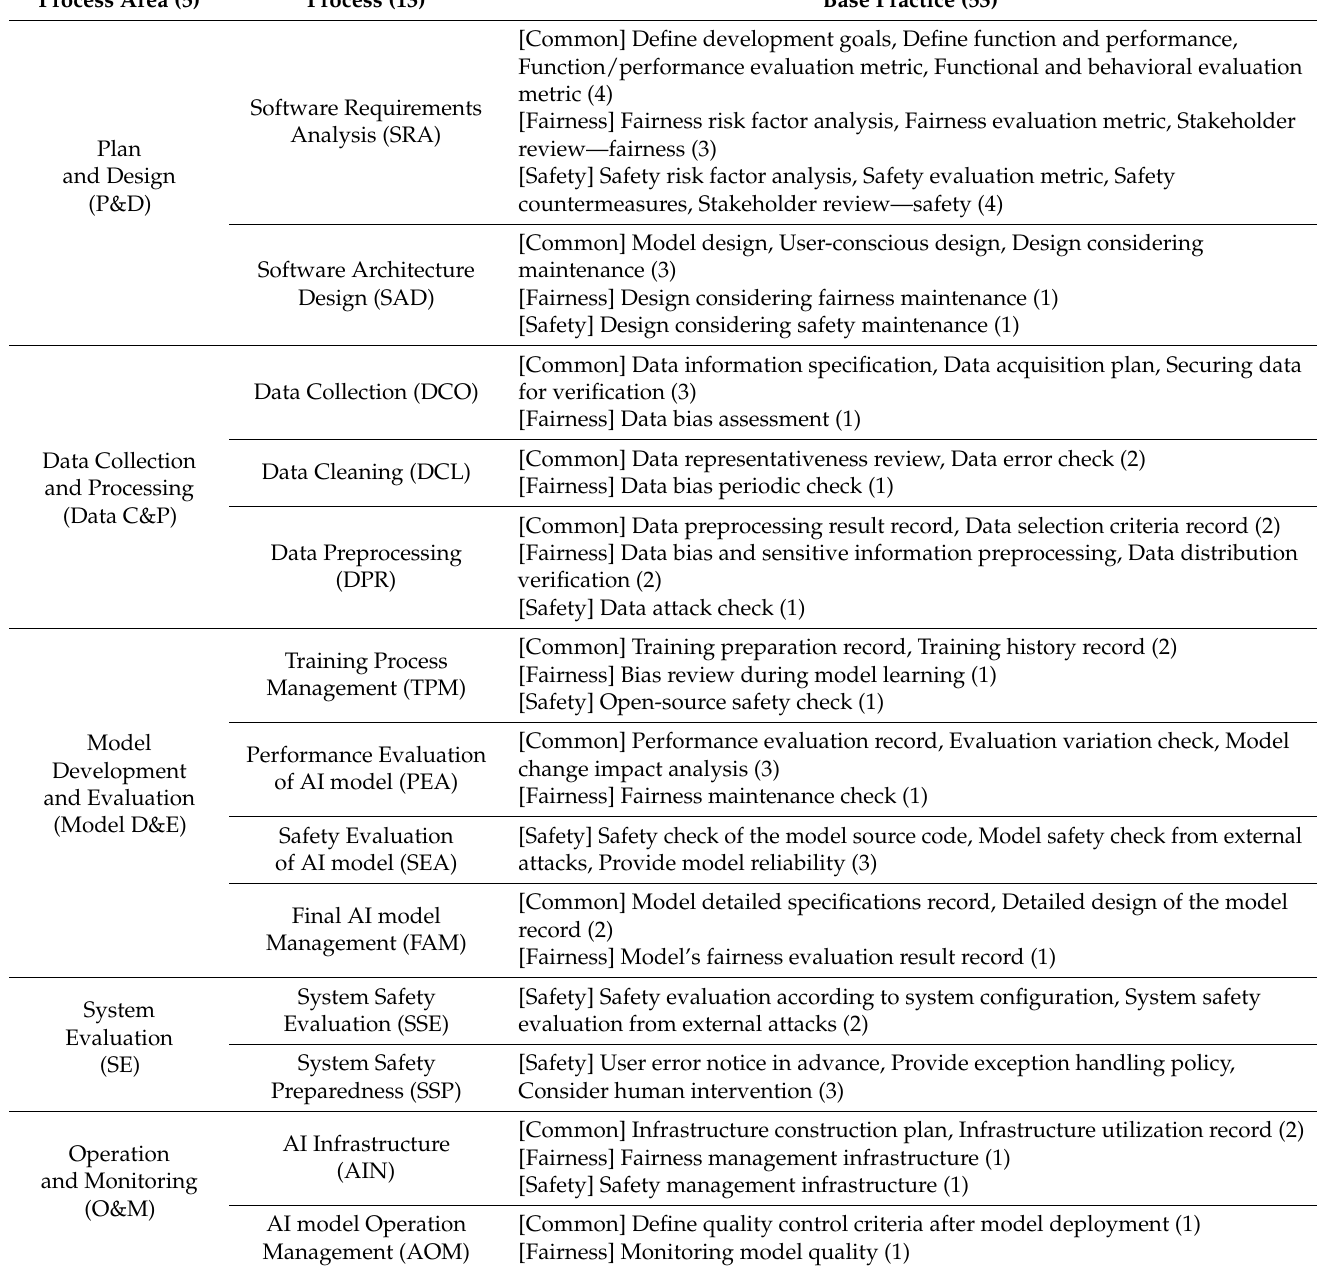
Table 3. Process dimensions of